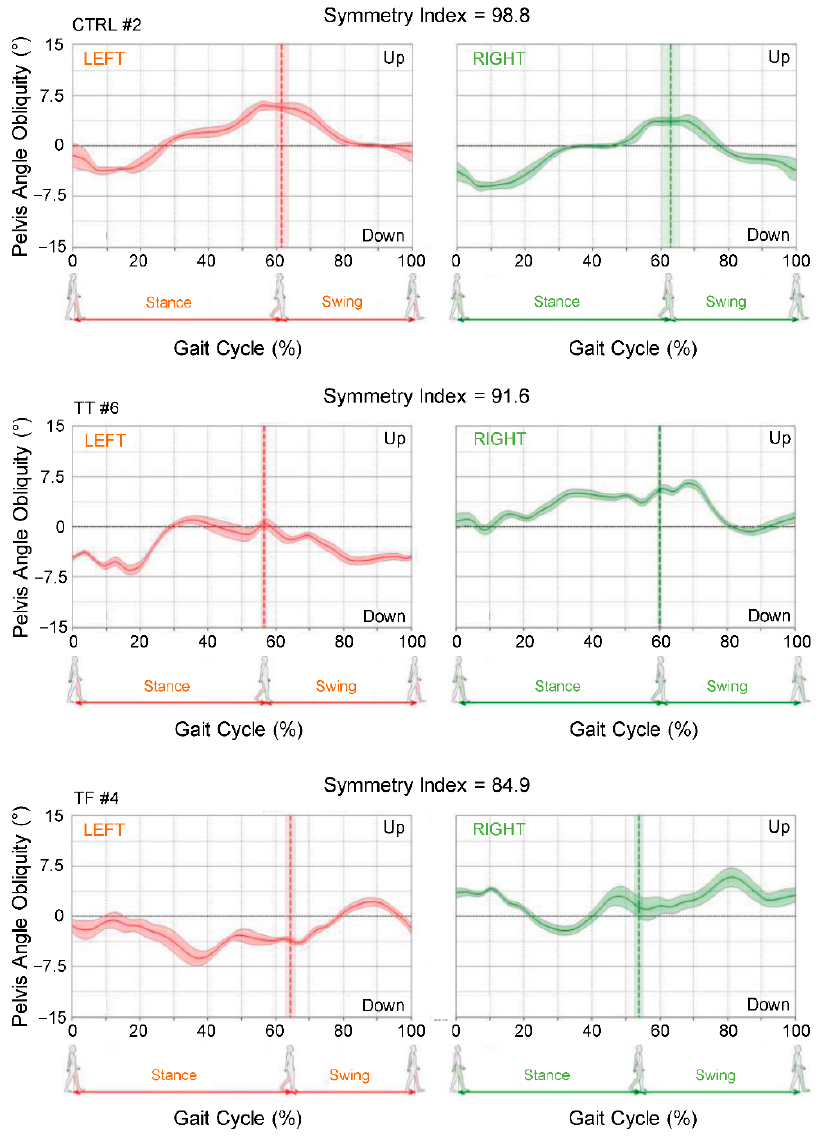
Figure 3. Representative examples of pelvis angle obliquity during gait cycle performed on the left and right sides by one control participant (CTRL), one transtibial amputee (TT) and one transfemoral amputee (TF). The waveforms represent the means and the standard deviations of pelvis angle obliquity from the total number of cycles during the 10-m walk test. The linear correlation between the left and the right pelvis angle obliquity, estimated by the Pearson correlation coefficient, was the basis for the gait cycle symmetry index. (See Section 2 for details).